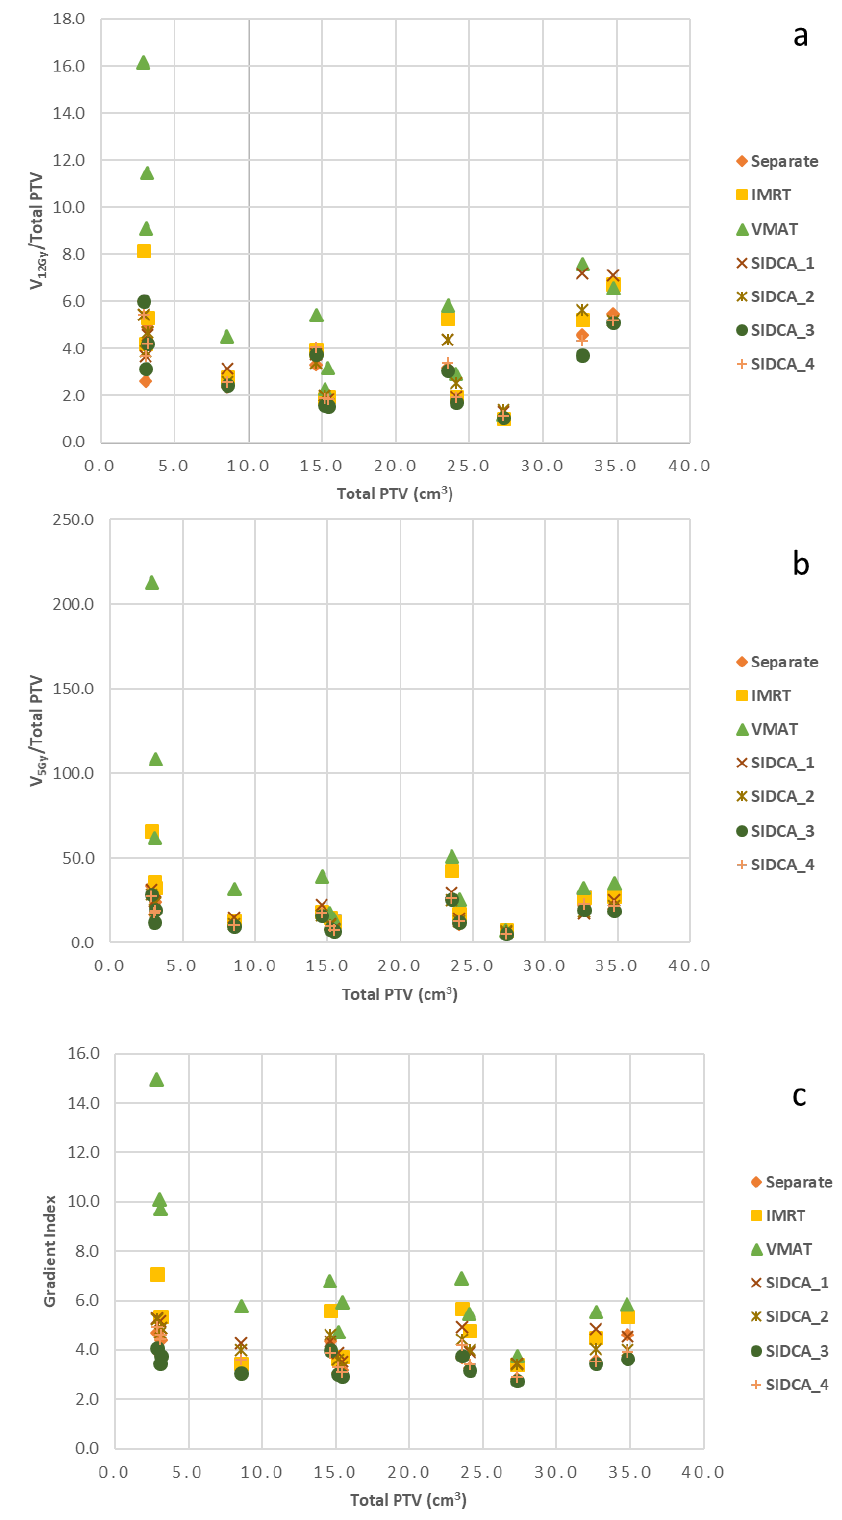
Figure 6. Graphs of the V 12Gy /(Total PTV) ( a ) and V 5Gy /(Total PTV) ( b ) of the uninvolved brain, and the gradient index ( c ) as a function of the total PTV for different plans.